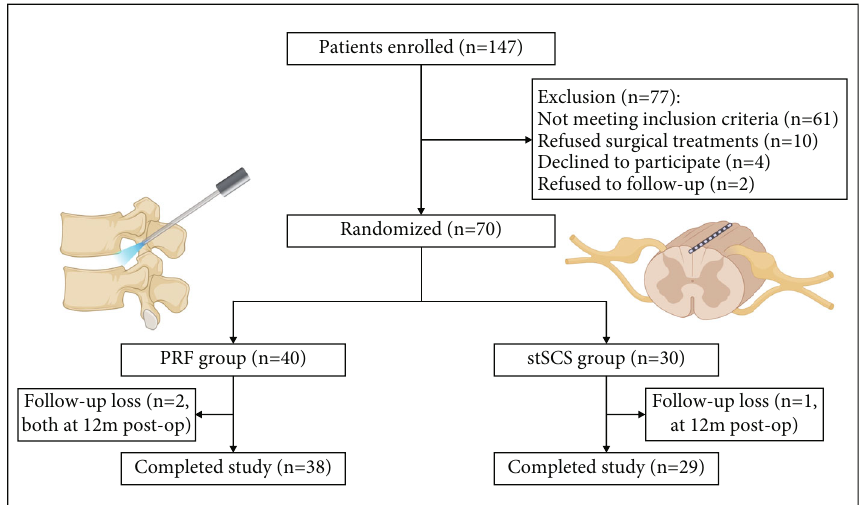
Figure 1: Study fl owchart. Seventy patients were randomly assigned to the PRF group and stSCS group. PRF: pulsed radiofrequency; stSCS: short-term spinal cord